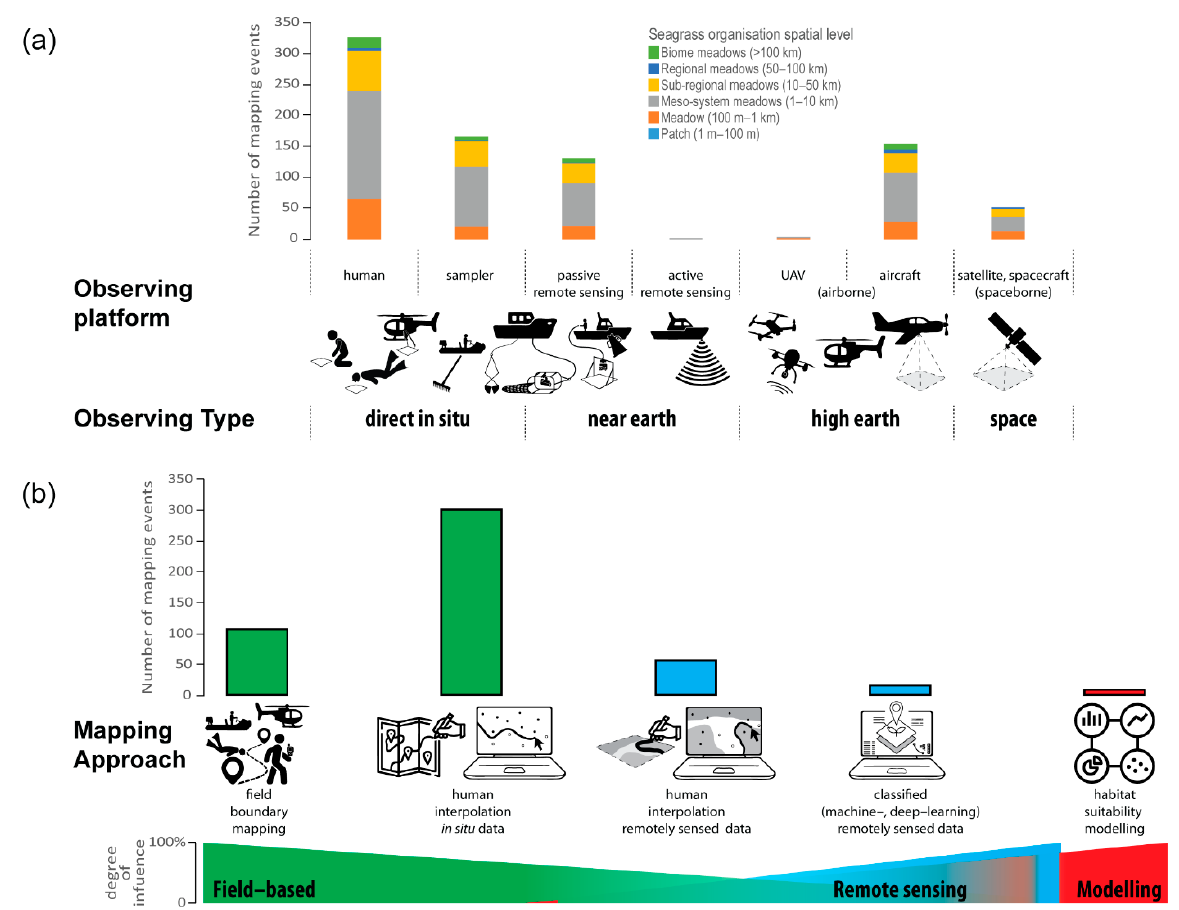
Figure 4. Frequency of occurrence of each earth observing platform type and seagrass organisation spatial level ( a ), and mapping approach ( b ) used to map seagrass meadows within the GBRWHA over the last century (1920–2020). The degree of influence illustrates the contribution of each broad group- ing to specific mapping approaches: green = field-based, blue = remote sensing, and red = modelling. See Table 2 for seagrass organisation level and Table 3 for observing platform and type. Source data provided in Table